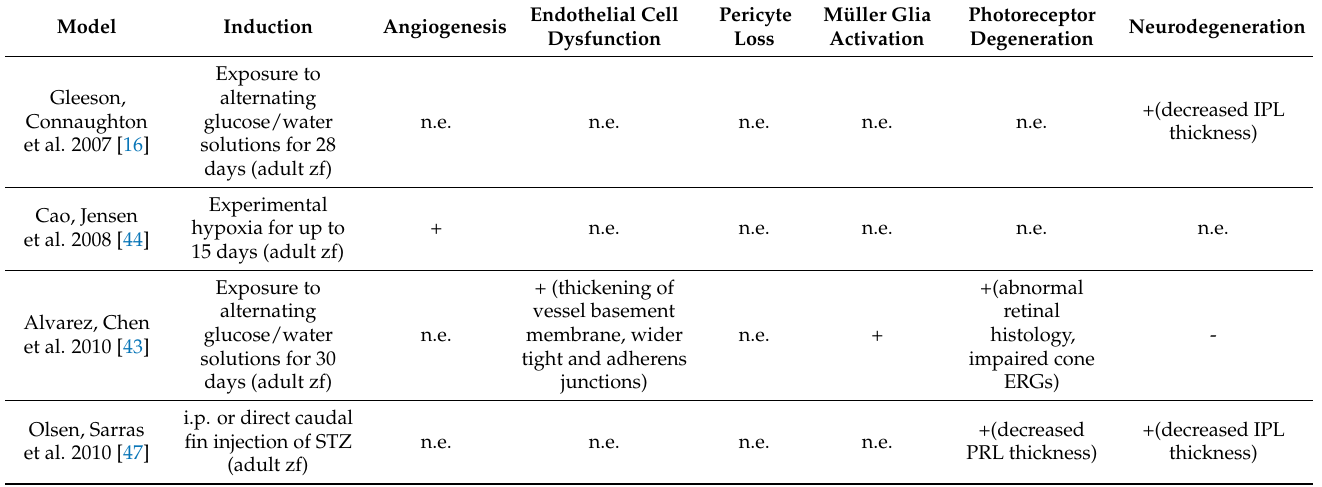
Table 1. Zebrafish models of diabetic retinopathy. Abbreviations: 4-HNE = 4-hydroxynonenal, dpf = days post fertilization, GCL = ganglion cell layer, GS = glutamine synthetase, hpf = hours post fertilization, i.p. = intraperitoneal, INL = inner nuclear layer, IPL = inner plexiform layer, MG = methylglyoxal, n.e. = not evaluated, ONL = outer nuclear layer, OPL = outer plexiforme layer, RGC = retinal ganglion cell, STZ = streptozotocin, “+” indicates positive